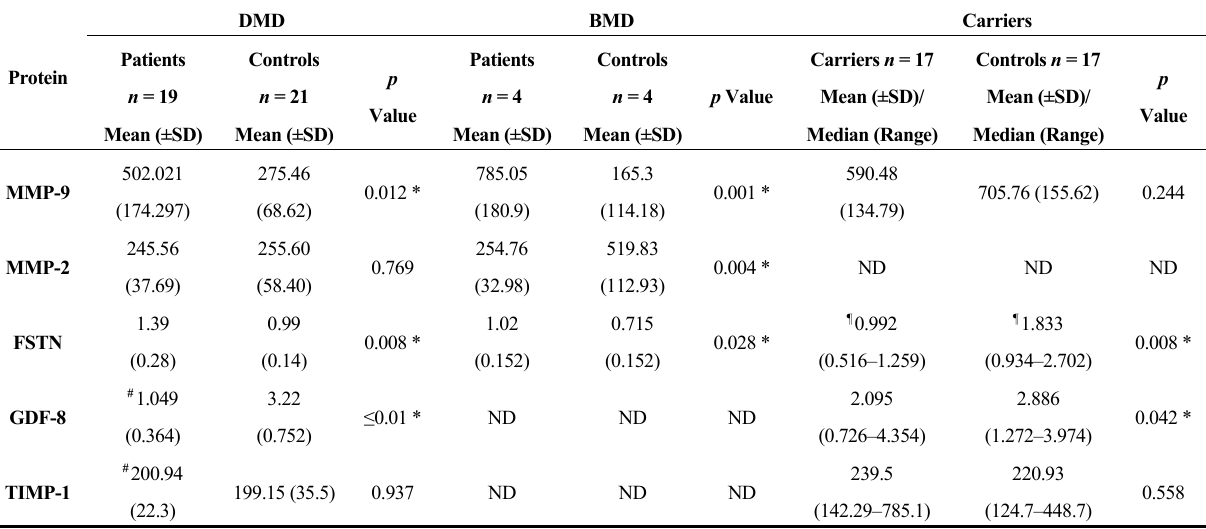
Table 1. Comparison of protein serum levels in DMD, BMD and female carriers (matched by